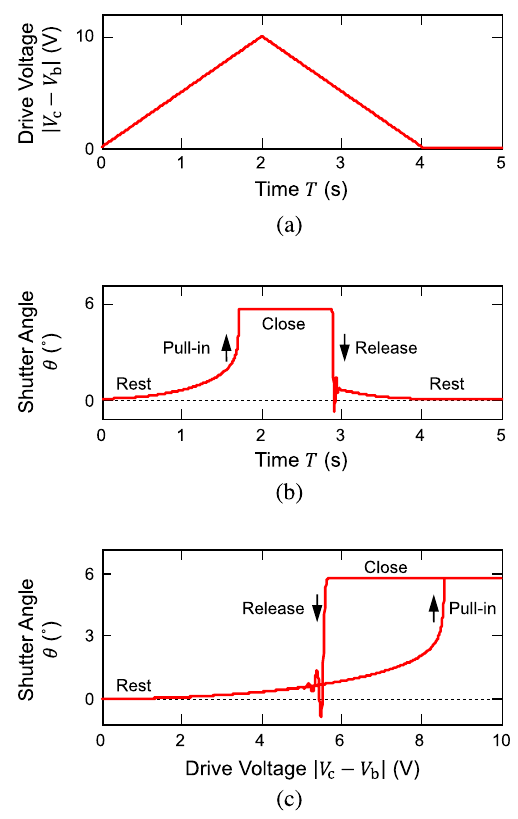
Figure 5. Equivalent-circuit simulation results of electrostatic shutter operation (rest-close). ( a ) Drive voltage waveform used for simulation and ( b ) calculated shutter angle waveform. ( c ) Alternative presentation of the shutter angle as a function of drive voltage. Electrostatic hysteresis loop has been reproduced by simulation.